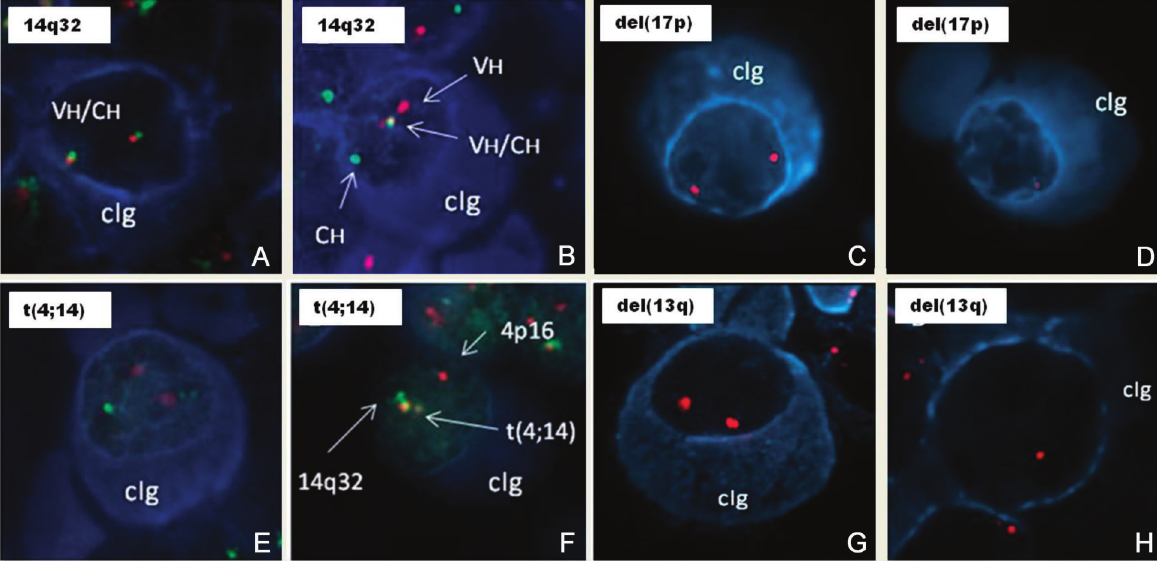
Figure 1. Genetic abnormalities in multiple myeloma. Representative images from the cIg-FISH results. Plasma cells are identi fi ed by the blue cytoplasmic stain, which indicates the presence of either cytoplasmic kappa or lambda light chains (cIg). A and B, analysis with a break-apart probe spanning the IGH locus identi fi es one pair of juxtaposed red (centromeric) and green (telomeric) signals, and one pair of split red and green signals consistent with an IGH translocation. C and D , analysis with LSI TP53 probe, normal nuclei and nuclei containing deletion of one copy of the 17p13 regions of a chromosome 17 as indicated by the single red signal. E , analysis with a dual fusion probe for t(4;14)(p13;q32) identi fi es two separate red (MMSET) and green (IGH) signals, indicating absence of the IGH/MMSET translocation. F , abnormal malignant plasma cell hybridized with the probe for t(4;14)(p13;q32) shows separate red (MMSET) and green (IGH) signals, and one juxtaposed (fusion) signal, identifying this IGH translocation as t(4;14)(p13;q32). G and H, analysis with LSI D13S319 probe, normal nuclei and nuclei containing deletion of one copy of the 13q14 regions of a chromosome 13 as indicated by the single red